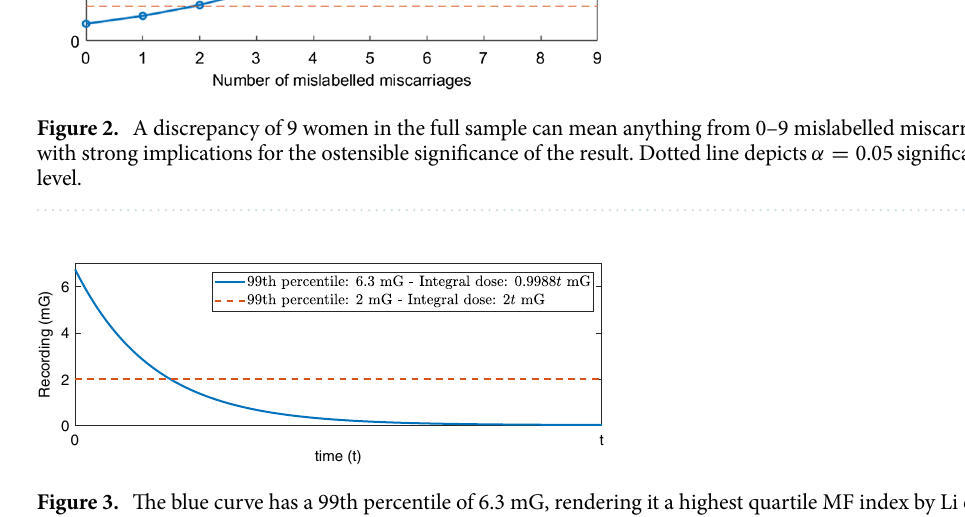
Figure 3. The blue curve has a 99th percentile of 6.3 mG, rendering it a highest quartile MF index by Li et al’s schema. The red curve would be in the lowest quartile with a 99th percentile of only 2 mG, yet the woman whose exposures are recorded on the red curve would receive more than double the total dose of the participant whose exposure follows the blue